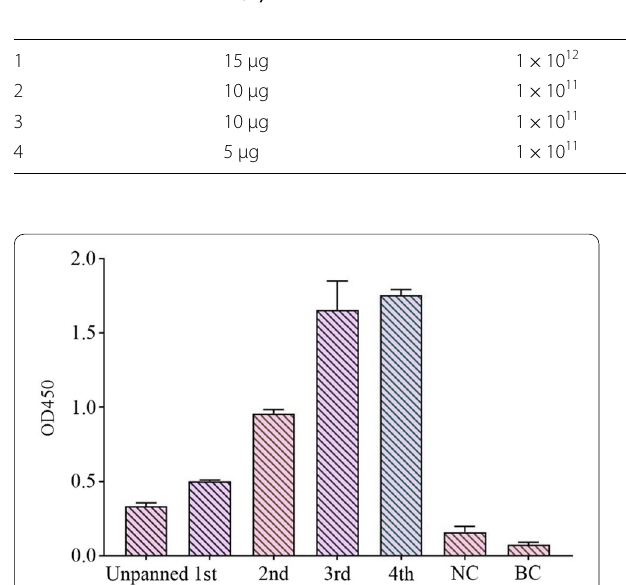
Fig. 3 ELISA for 4 rounds of bio-panning phage library. Samples from round 1–4, phage in each of 4 rounds of bio-panning procedure. Unpanned sample: the primary scFv phage library. Negative control